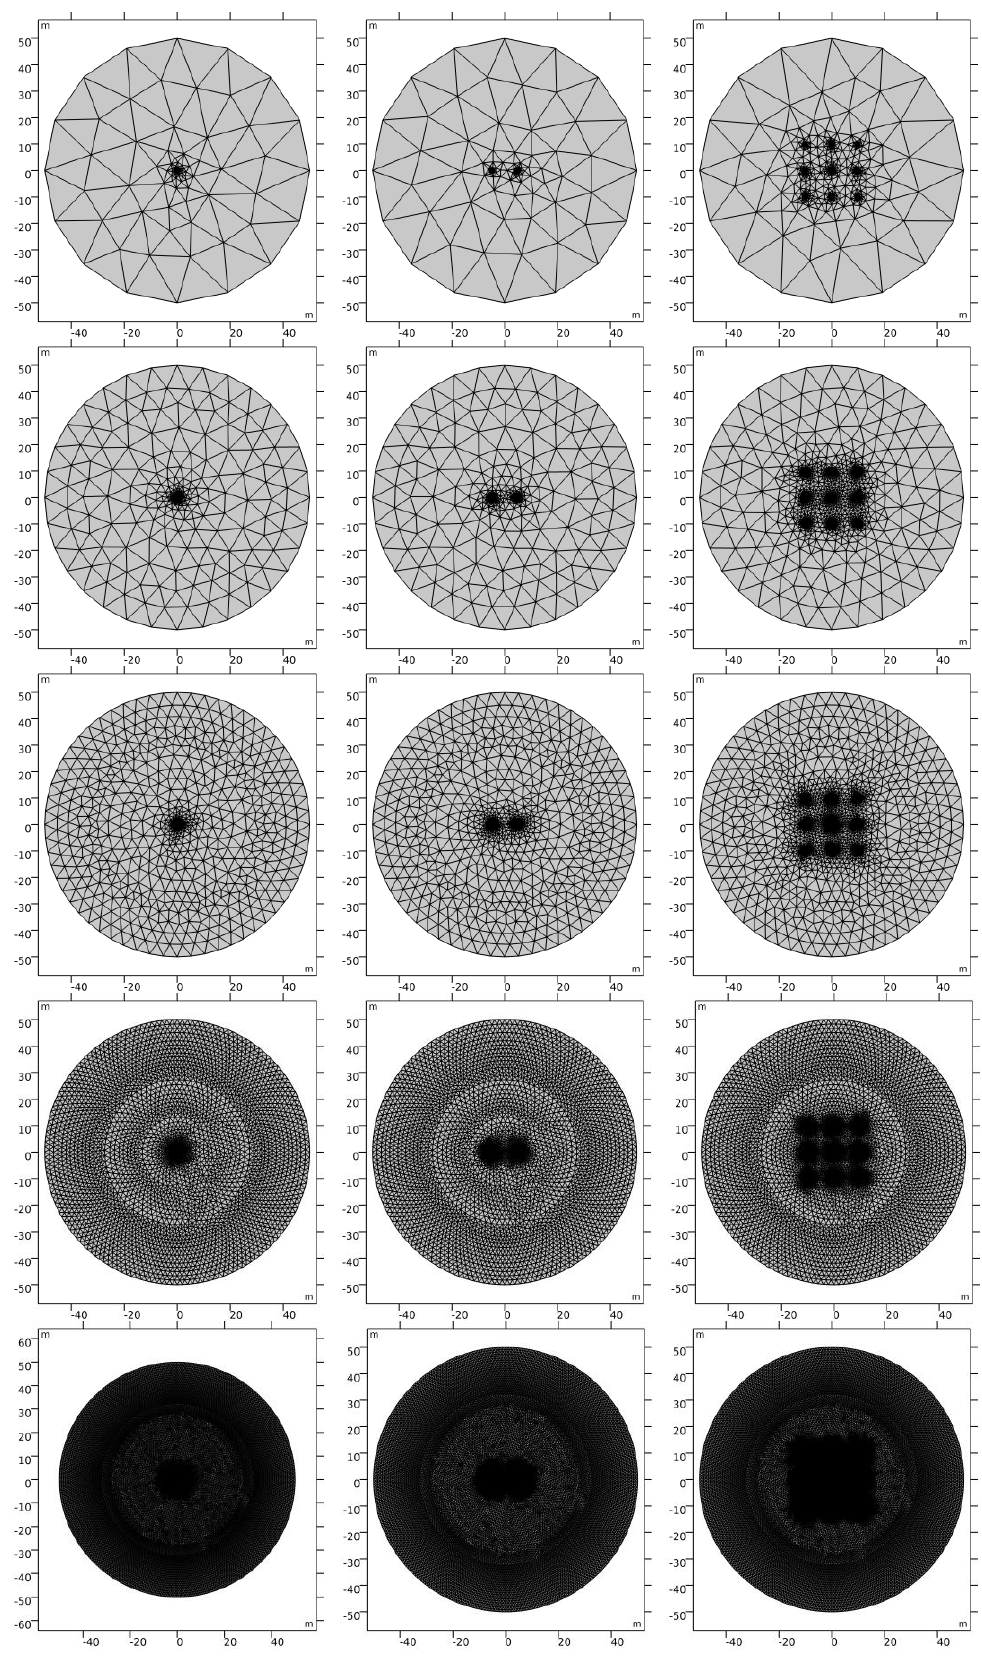
Figure A2. Unstructured mesh scenarios used: extra coarse, coarse, fine, extra fine, extremely fine (from up to bottom); single borehole, double boreholes, 3-by-3 boreholes (from left to